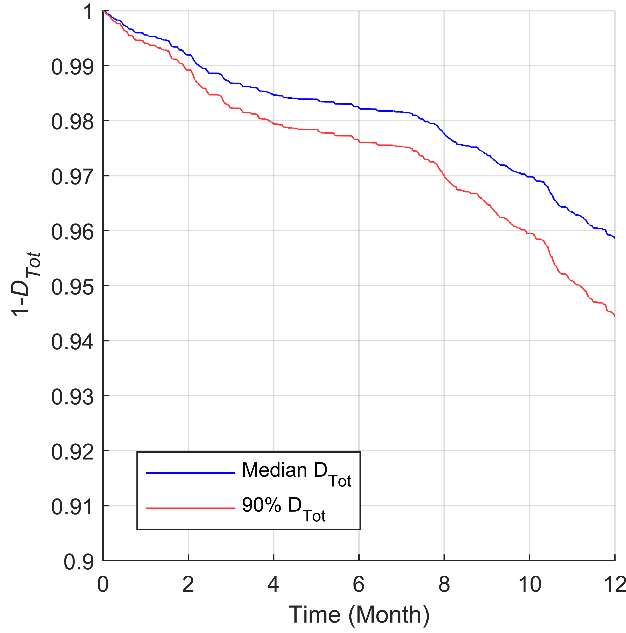
Figure 12. Graphic of 1 − D Tot for 1 WT imposing TI = 10% for a 1-year period. In blue, the median D Tot , computed with the 50th percentile of D HCF . In red, 90% D Tot , computed with the 90th percentile of D HCF .